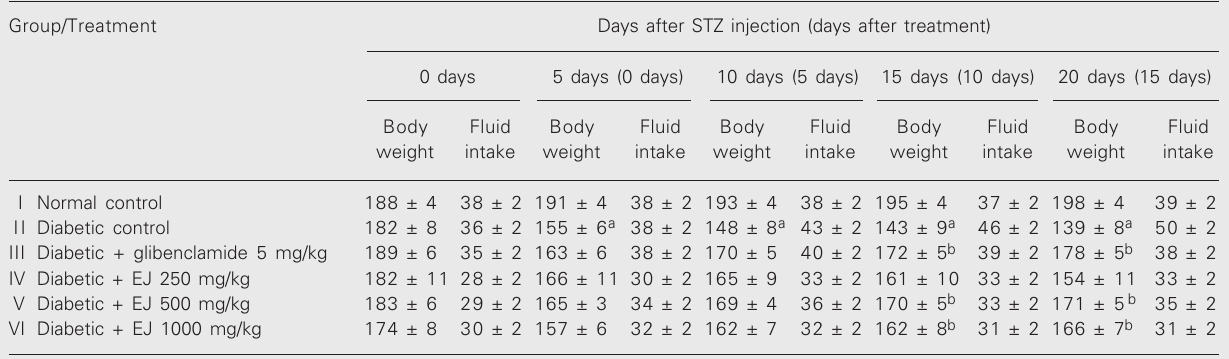
Table 1. Effect of Eugenia jambolana seed powder on body weight (g) and fluid intake (ml/24 h) of streptozotocin-diabetic rats.